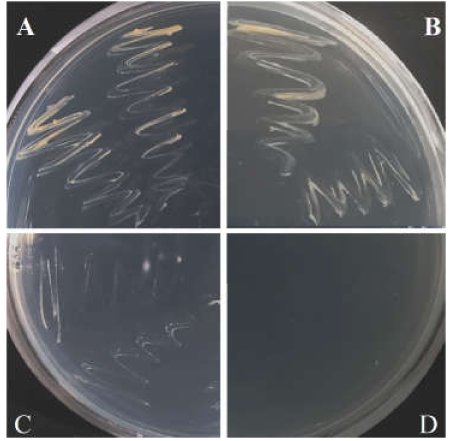
Figure 7. Growth of the isolate of Mycobacterium sp. related to the M. cookii strain ATCC 49103 cultivated for 30 days on Actinobacteria Isolation Agar ( A ), medium supplemented with 250 mg L − 1 timentin ( B ), 30 mg L − 1 chloramphenicol ( C ), or 25 mg L − 1 rifampicin ( D